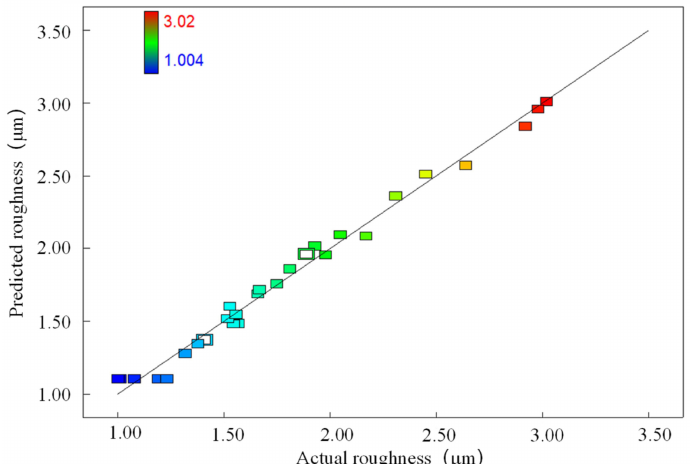
Figure 2. Predicted and actual values of surface roughness.